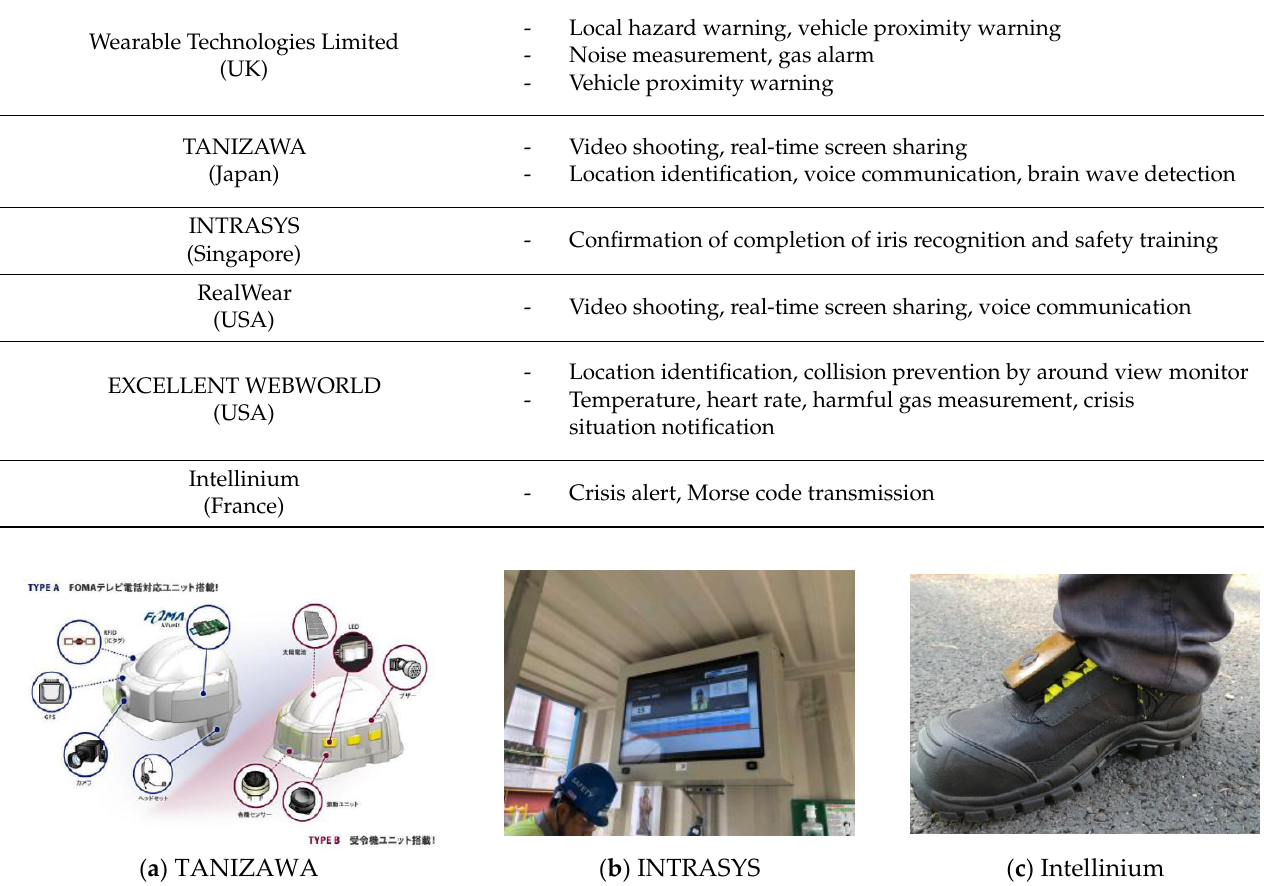
Figure 4. Smart construction safety equipment in major